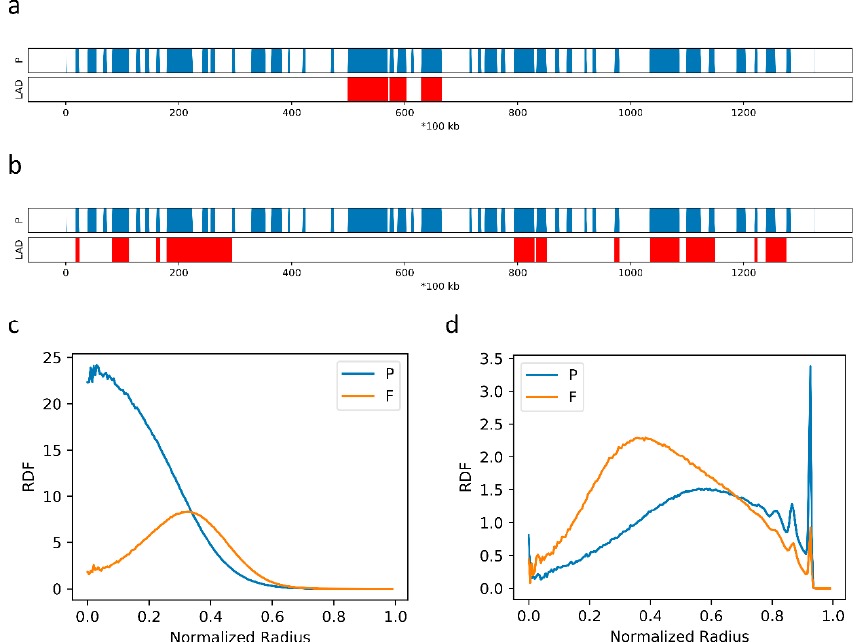
Figure 6. ( a , b ) The P-domain and LAD annotation of chr10 from two single-cell samples; ( c ) the RDFs obtained from the chr10 simulation of samples in Figure 6a; ( d ) the RDFs obtained from the chr10 simulation of samples in Figure 6b.